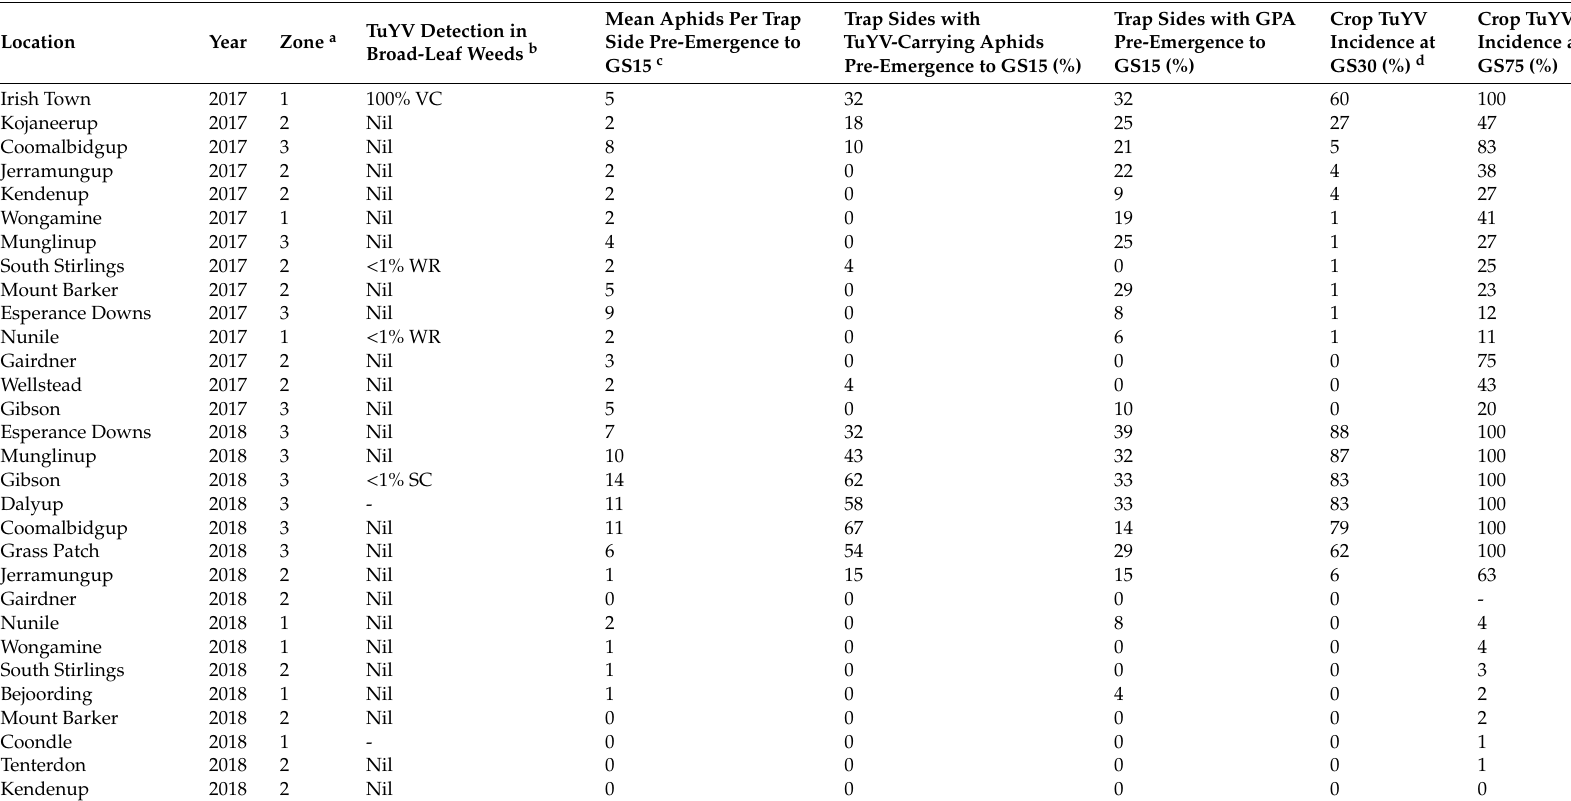
Table 2. Turnip yellows virus (TuYV), aphid number and green peach aphid (GPA; Myzus persicae ) data collected at 30 sites sown to canola ( Brassica napus ) in the south-west Australian grainbelt in 2017 and